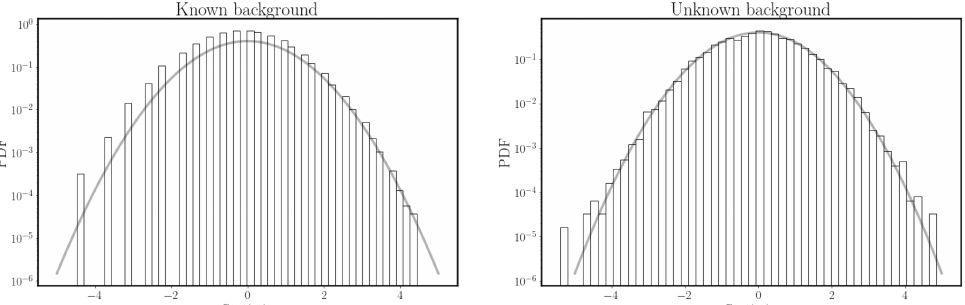
Figure 5. Distribution of the Cash statistic in Equation (24) ( left panel ) and the Li&Ma statistic in Equation (28) ( right panel ) from measurements in which the background is known precisely to be ¯ b = 10 or must be estimated from the OFF counts N = 1, respectively. In both simulations, of f with α the true values of s and b are 0 and 10, respectively. In both plots, the PDF of a normal distribution with mean zero and variance 1 is shown in grey as reference. In both cases 10 6 simulations were performed. The distribution in the left panel looks to be less populated due to the fact that having the background fixed to 10 (and not estimated from an OFF measurement) limits the number of possible outcomes of the